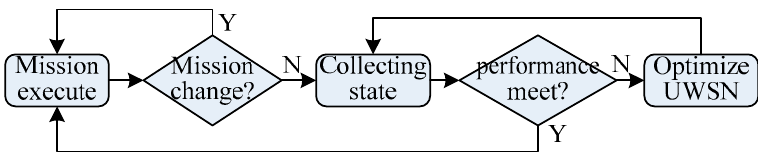
Figure 6. Process of UWSN optimization.